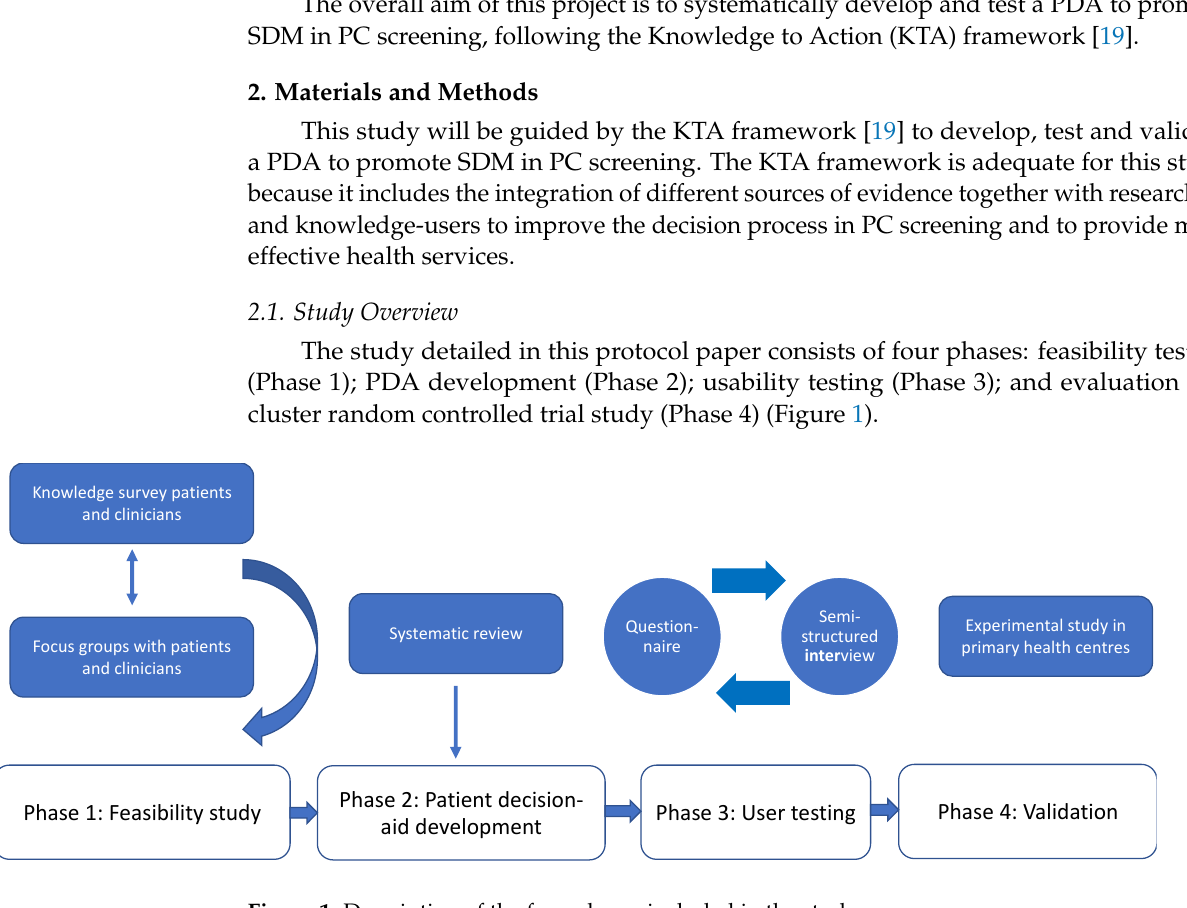
Figure 1. Description of the four phases included in the